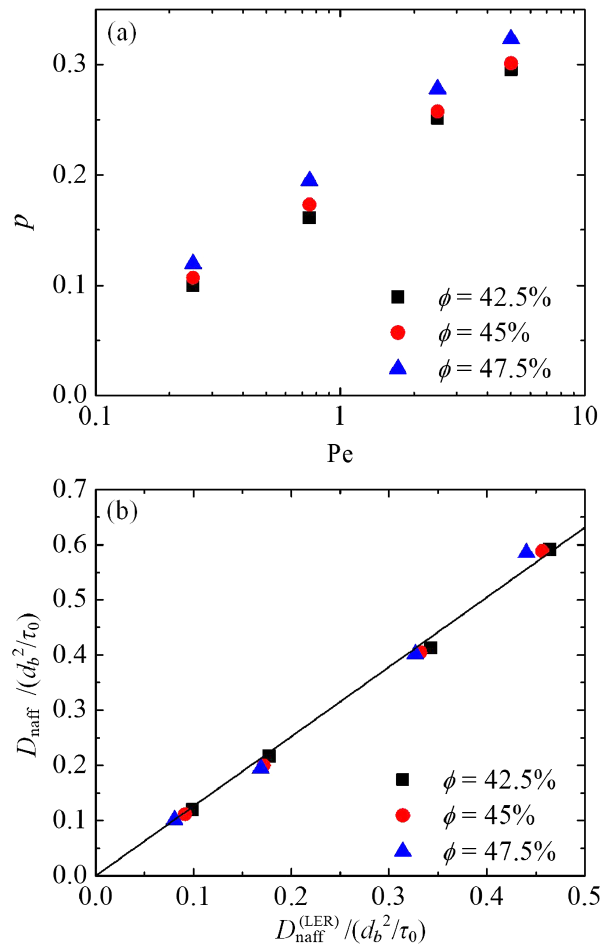
FIG. 9. (a) p as a function of Pe in the nonlinear regime. (b) Scatter plot of D and D ð LER Þ . The solid line denotes the naff naff 1 . 26 D ð LER Þ relation D naff ¼ naff